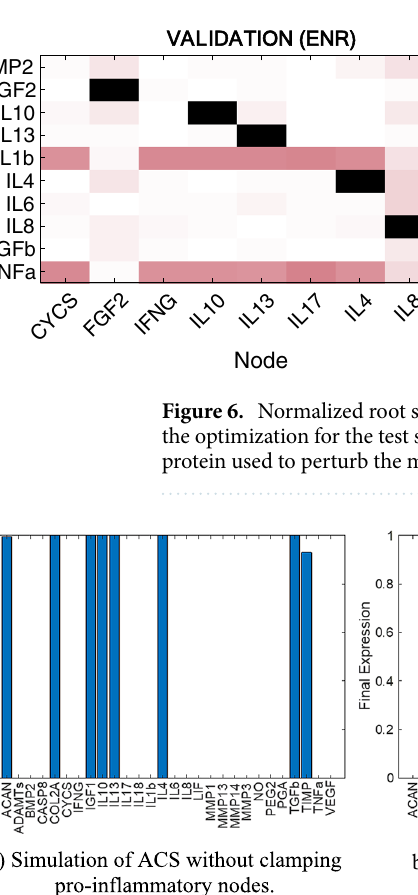
Figure 7. Proof of Concept steady states for each scenario. ( A ) First scenario: optimized network simulated with autologous conditioned serum (ACS). ( B ) Second scenario: Proinflammatory nodes of the optimized stimulation at their maximum capacity along with ACS stimulation to simulate an osteoarthritic joint or environment. ( C ) Third condition: proinflammatory nodes of the optimized stimulation at half of their maximum capacity along with ACS stimulation to simulate an osteoarthritic joint or environment with partial modulation of proinflammatory